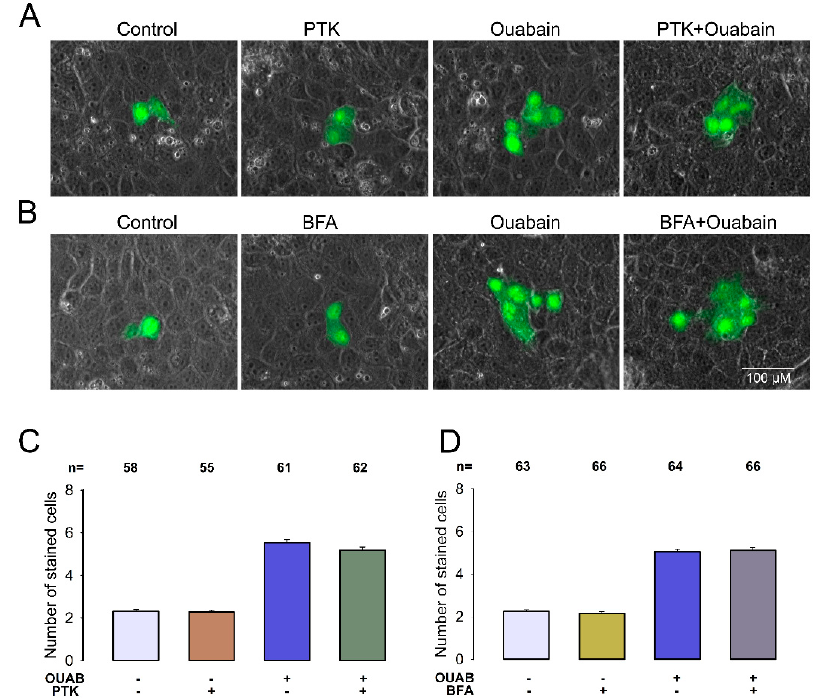
Figure 3. The molecular component contained in CM that causes GJIC in MDCK-I cells is not a protein. ( A , B ) Images showing representative examples of dye transfer trials to assay the effect of proteinase K (Pt K) and brefeldin A (BFA) respectively. The green mark corresponds to LY dye, whereas the gray background is a phase contrast field showing the integrity of the monolayer. The images were selected to match the median of each indicated experimental condition. ( C , D ) Bar charts comparing aNSC ( ± SE) in the experimental condition indicated at the bottom of each bar. ( C ) shows the effect of proteinase K and ( D ) the effect of Brefeldin A. No statistically significant difference was found between groups. The values above bars indicate the number of repetitions.